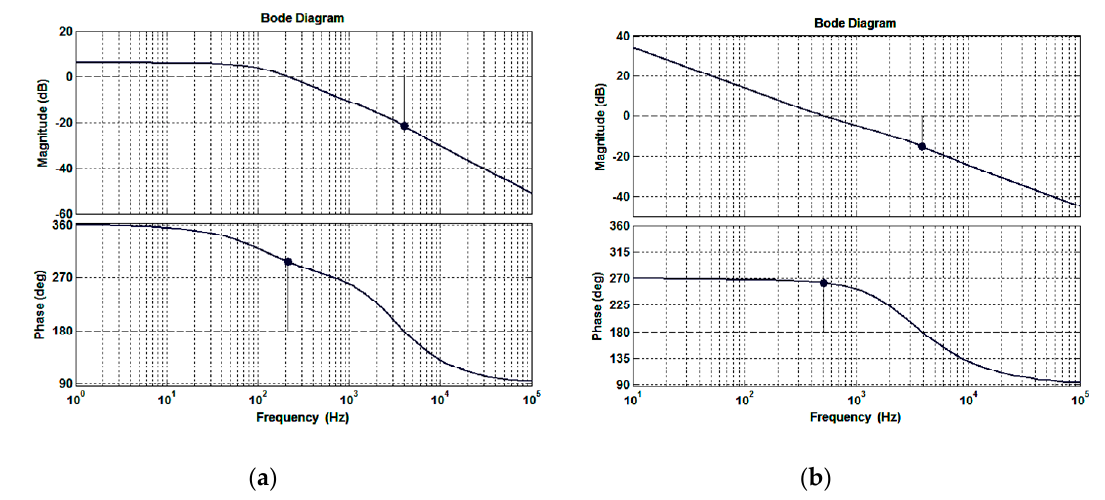
Figure 12. Frequency characteristic of the voltage loop gain ( a ) without compensation; ( b ) with compensation.